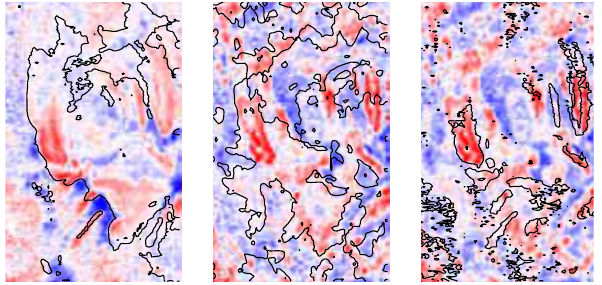
Fig. 6. A similar relationship is observed in the active region loops already shown in Fig. 1: magnetically confined structures are out- lined by brightness contours within Ne VIII shifts (left) and within O IV shifts (center); structures are also outlined by Ne VIII redshift contours within O IV shifts (right).